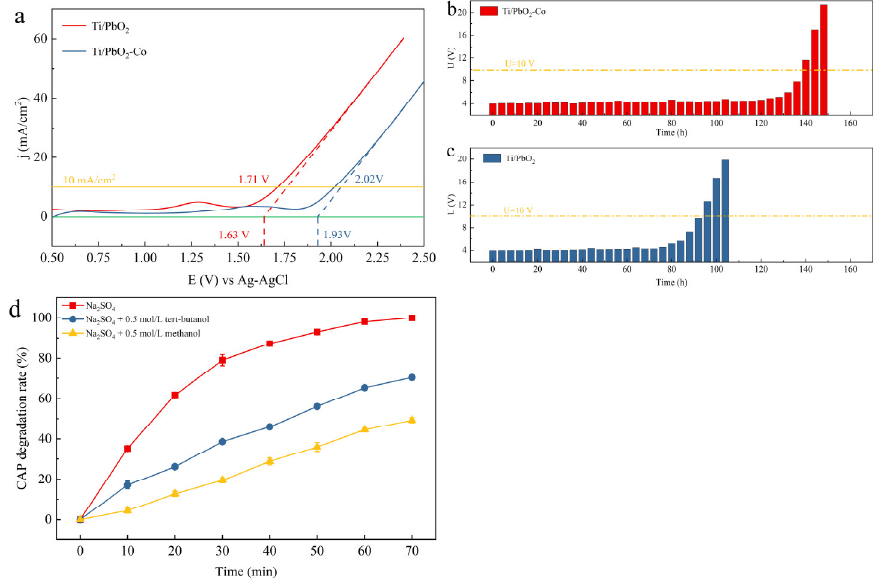
Figure 5. ( a ) LSV test of the Ti/PbO 2 electrode; ( b ) accelerated life test for the Ti/PbO 2 and ( c ) Ti/PbO 2 - Co electrodes; ( d ) free radical capture diagram.